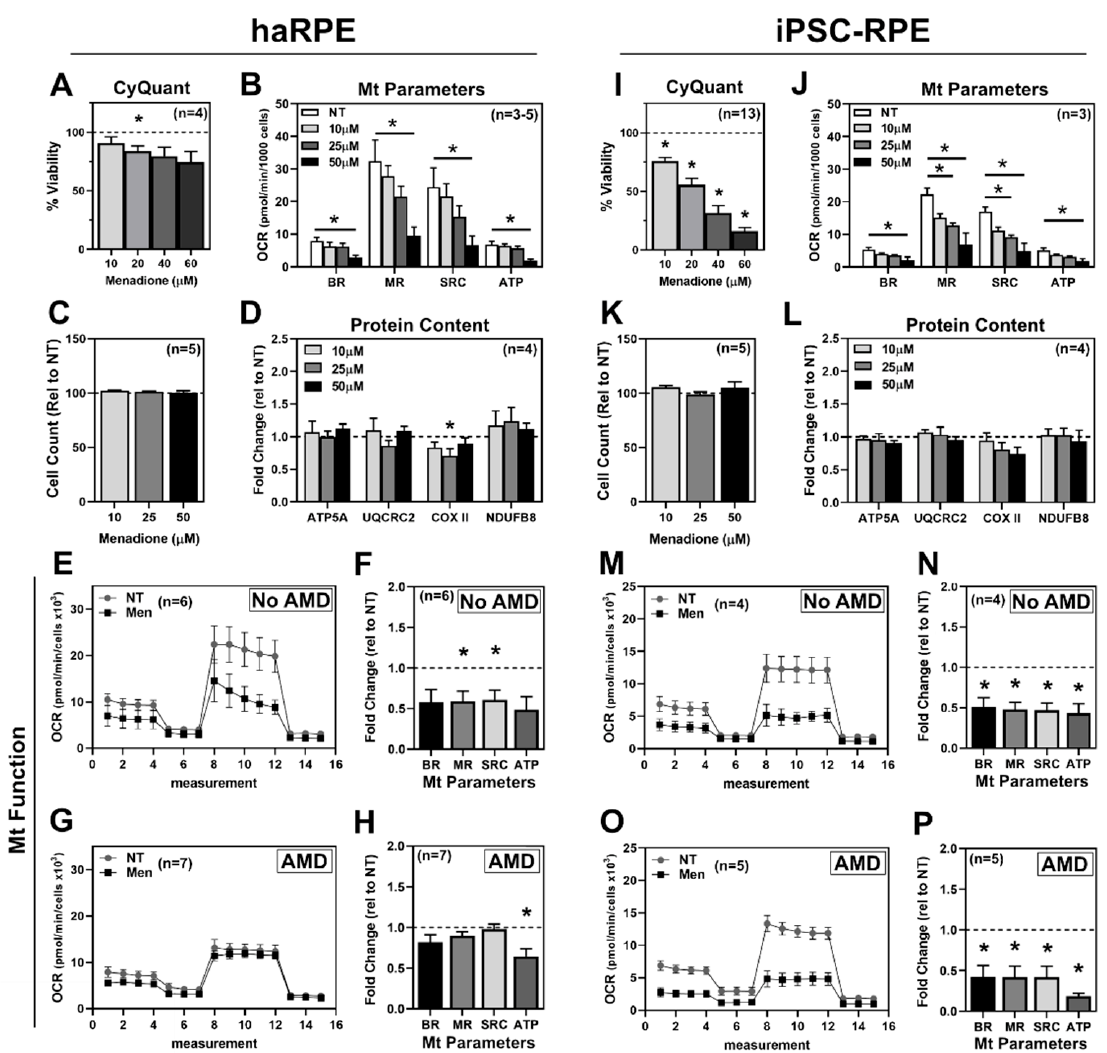
Figure 2. Response to the mitochondrial stressor menadione. haRPE ( A – H ) or iPSC-RPE ( I – P ) were treated with different doses of menadione for 24 h. ( A , I ) Cell viability measured under non-confluent conditions. ( B , J ) Mitochondrial (Mt) function as measured by CMST. ( C , K ) Cell count under confluent conditions. ( D , L ) Quantification of mitochondrial proteins. ( E , M ) OCR trace from No AMD donors for no treatment (NT) or after treating with 25 µ M menadione. ( F , N ) Mitochondrial functional parameters for No AMD donors. ( G , O ) OCR trace from AMD donors for no treatment (NT) or after treating with 25 µ M menadione. ( H , P ) Mitochondrial functional parameters from AMD donors. Sample size is indicated in each panel. * denotes p < 0.05.